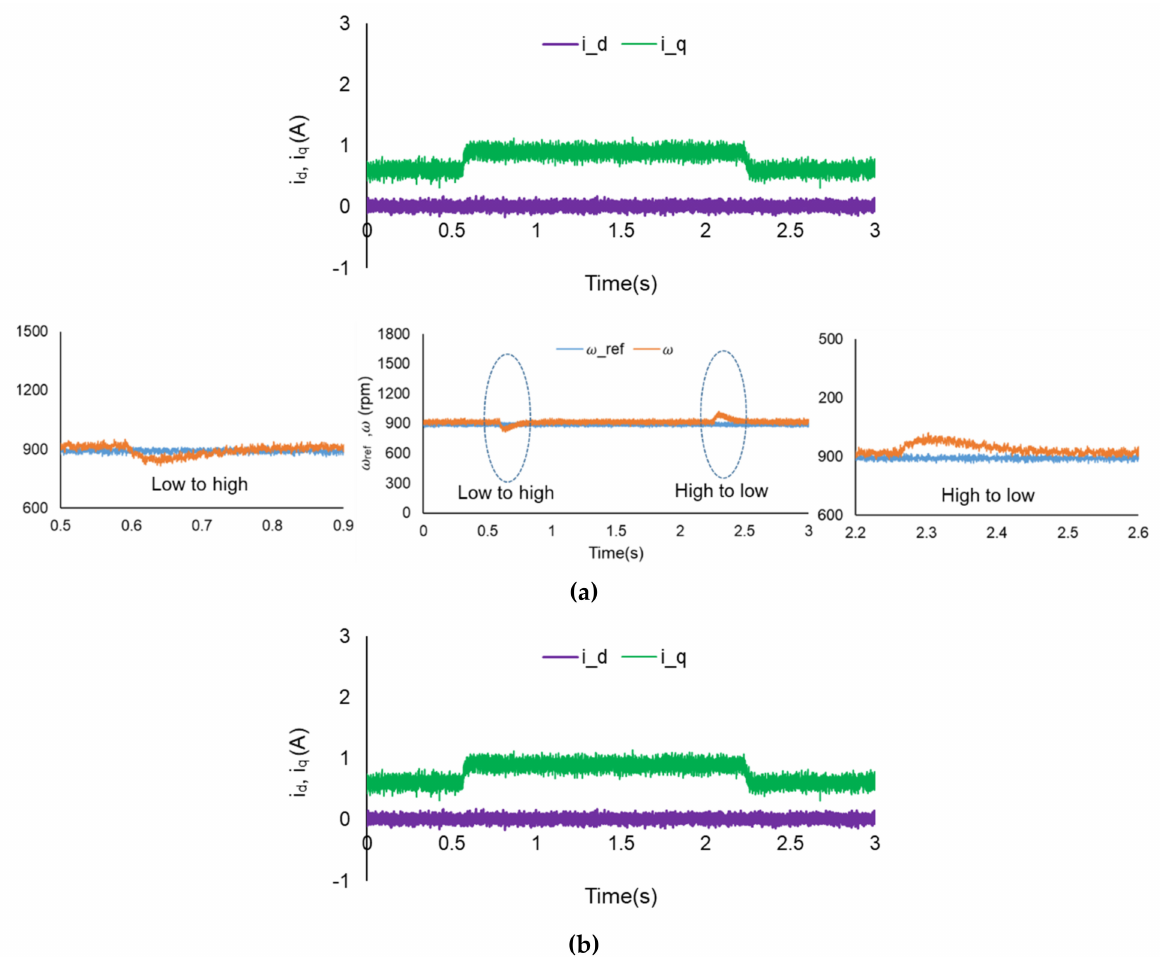
Figure 13. ( a ) Motor speed response; ( b ) current response for the sampling frequency of 25 kHz.